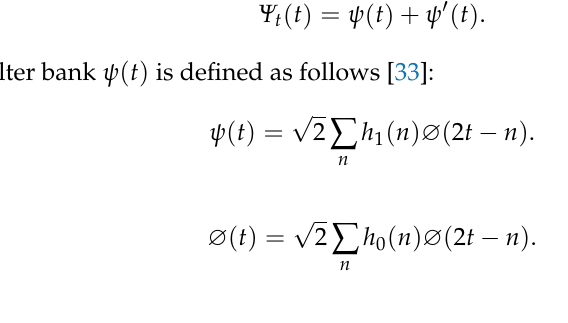
Figure 4. DT-CWT wavelet conversion scheme with four decomposition steps.